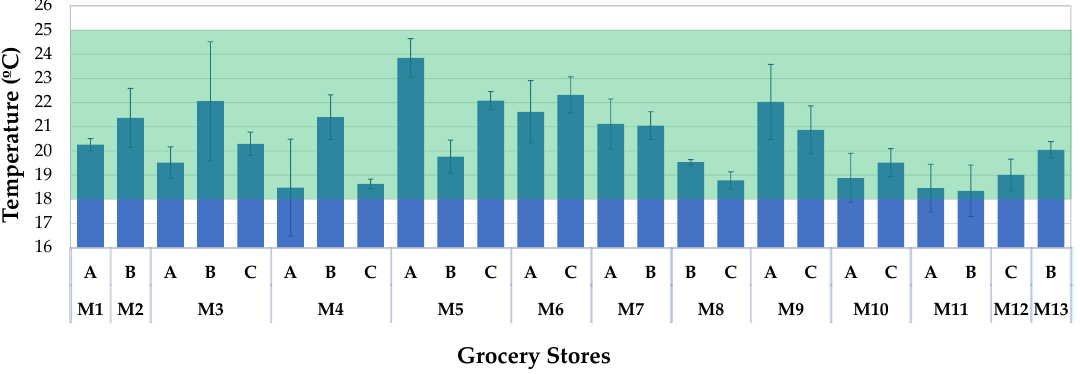
Figure 2. Temperature levels assessed in all locations of the studied GSs. The green area represents the acceptable range (18 °C – 25 °C) for workplaces defined by Portuguese Legislation [31].